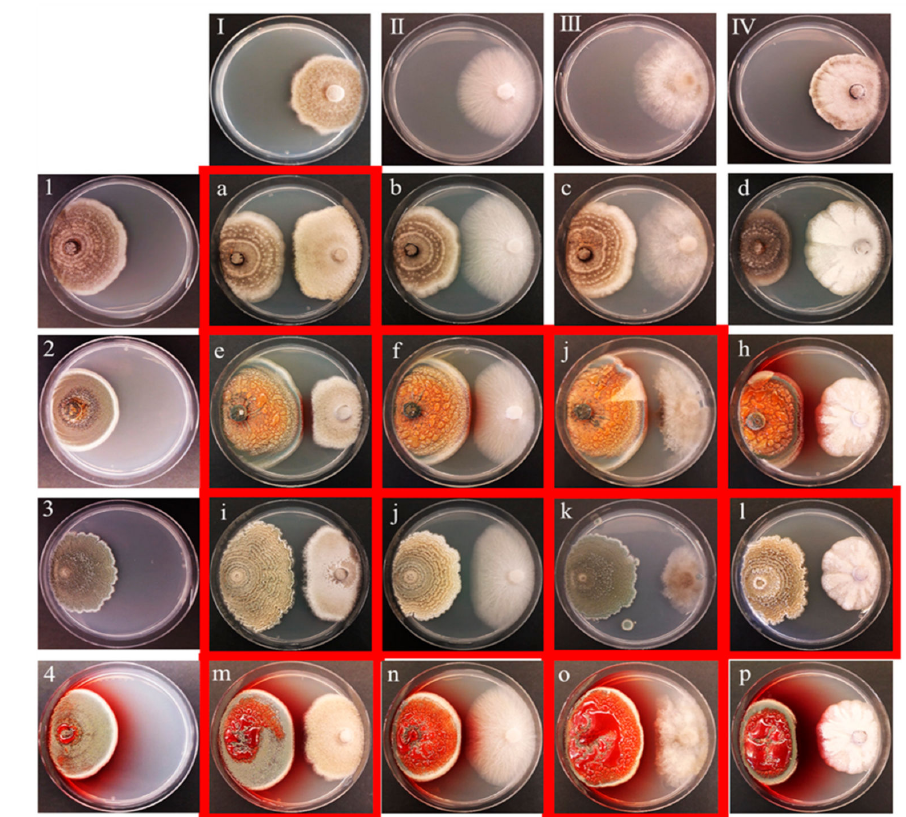
Figure 4. Co-culture experiments of four selected fungal endophytes and four fungal pathogens. Pathogens: ( I ), Alternaria alternata , ( II ), Fusarium oxysporum , ( III ), Botrytis cinerea , ( IV ), Colletotrichum acutatum . Endophytes: ( 1 ), EU11, ( 2 ), 4/3/2, ( 3 ), 5/3/2, ( 4 ), 11(2). Co-culture: ( a ), EU11 vs Alternaria alternata , ( b ), EU11 vs Fusarium oxysporum , ( c ), EU11 vs Botrytis cinerea , ( d ), EU11 vs Colletotrichum acutatum , ( e ), 4/3/2 vs A. alternate , ( f ), 4/3/2 vs F. oxysporum , ( g ), 4/3/2 vs B. cinerea , ( h ), 4/3/2 vs C. acutatum , ( i ), 5/3/2 vs A. alternata , ( j ), 5/3/2 vs F. oxysporum , ( k ), 5/3/2 vs B. cinerea , ( l ), 5/3/2 vs C. acutatum , ( m ), 11(2) vs A. alternata , ( n ), 11(2) vs F. oxysporum , ( o ), 11(2) vs B. cinerea , ( p ), 11(2) vs C. acutatum . The time for the pathogens to reach the middle of the plate was: B. cinerea 3 days, F. oxysporum 4 days, A. alternata 5 days, and C. acutatum 25 days. The time for endophytes to reach half of the plate was: 11(2) 17 days, 4/3/2 17 days, 5/3/2 17 days, and EU11 12 days. The fungi with slower growth rates were inoculated in the plate first and the second microorganism was placed on the point where both of them had the same days left to reach the center of the plate. Co-cultures in red squares show clear antifungal activity.